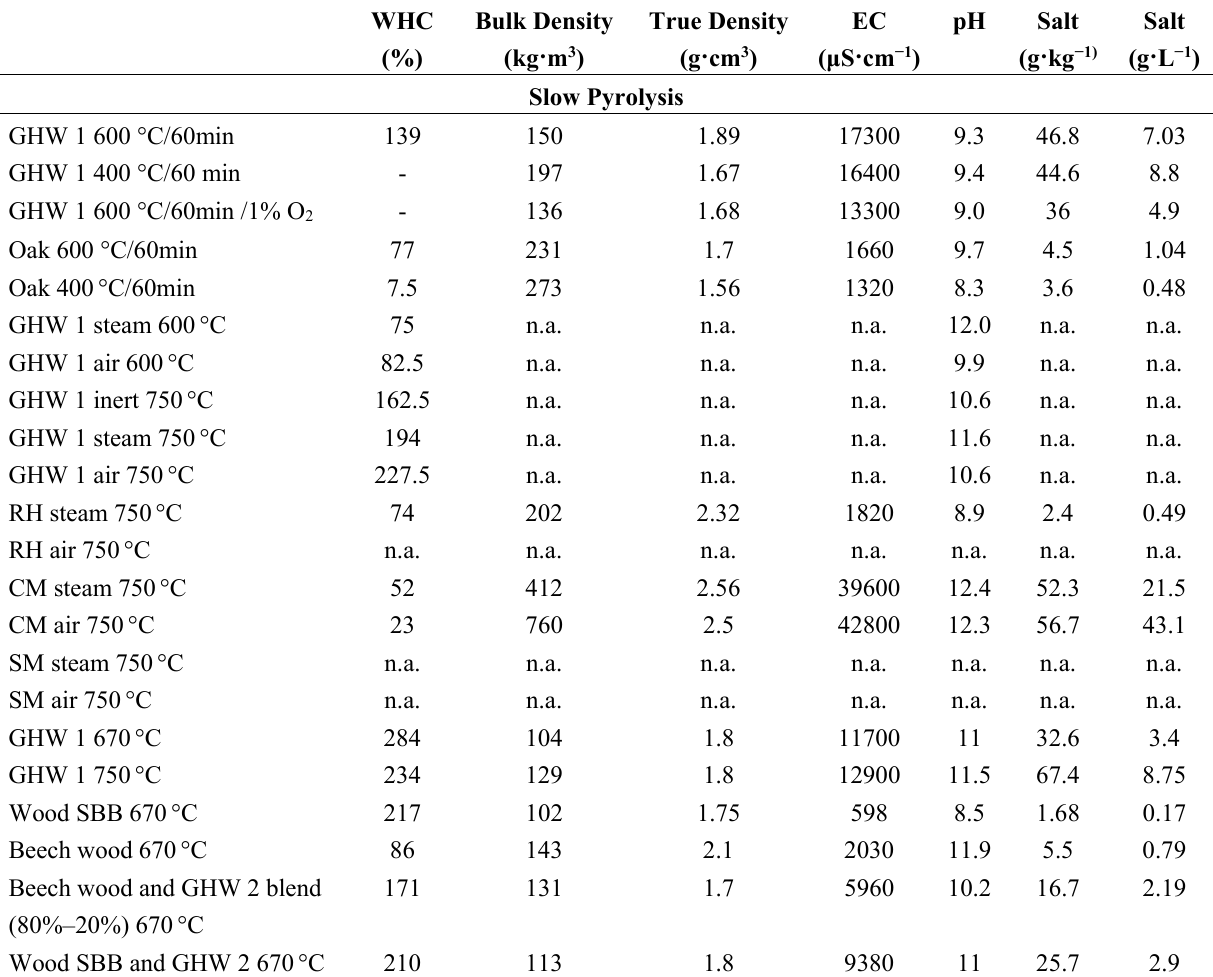
Table 5. Biochar properties of agronomic